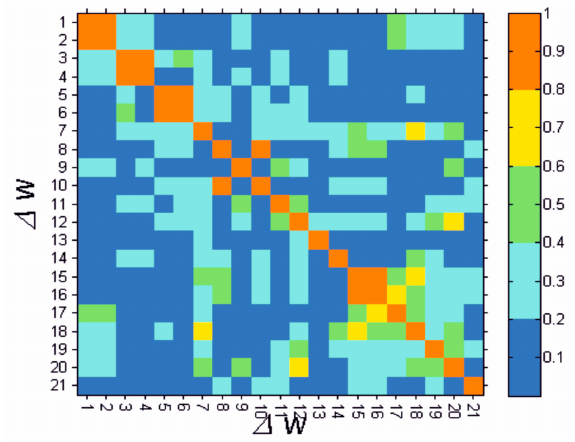
Figure 2. The matrix of correlation (the absolute values) for the difference of features from Δ w (1) to Δ w (21). The colour palette was accepted for determining the values of correlation. Blue, a feeble correlation; turquoise, a weak correlation; green, a moderate correlation; yellow, a strong correlation; and red, almost a complete correlation.